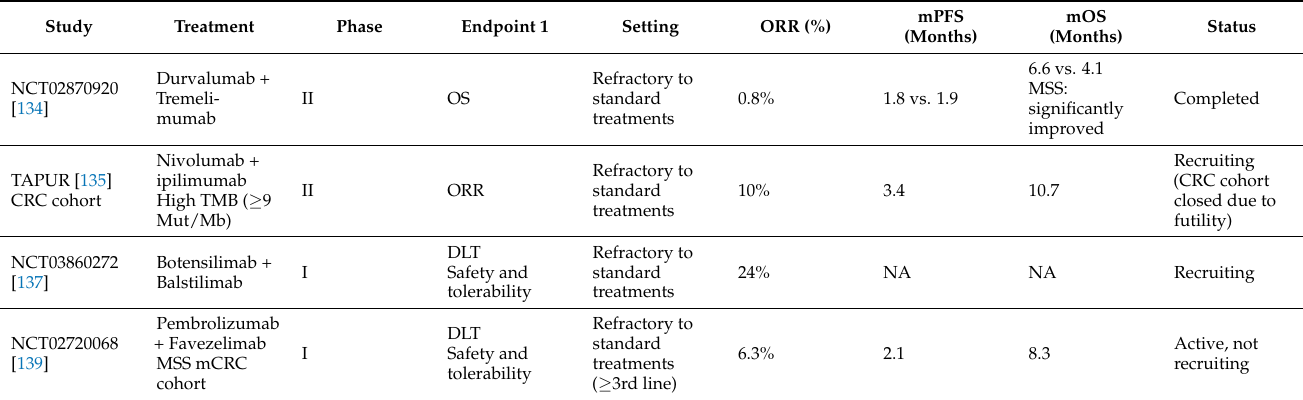
Table 8. Currently ongoing and completed clinical trials of combinations with other ICIs in MSS